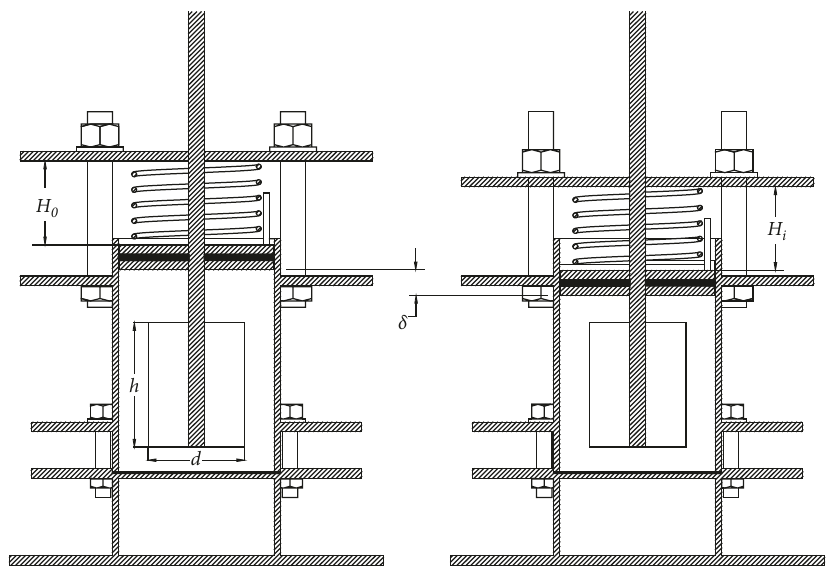
Figure 2: Schematic diagram of the device performing loading: (a) before loading; (b) after